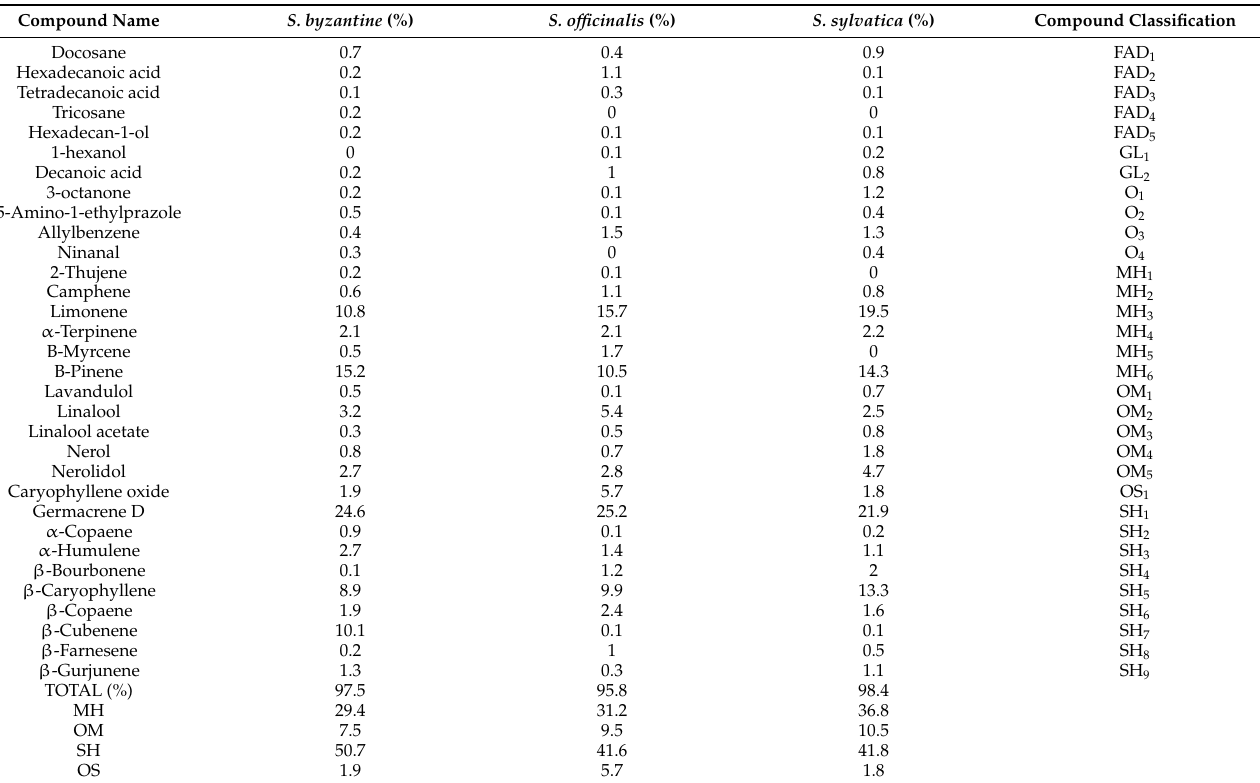
Table 2. The profile of volatile compounds from the three Stachys species: S. byzantina , S. officinalis , S. sylvatica . Compound